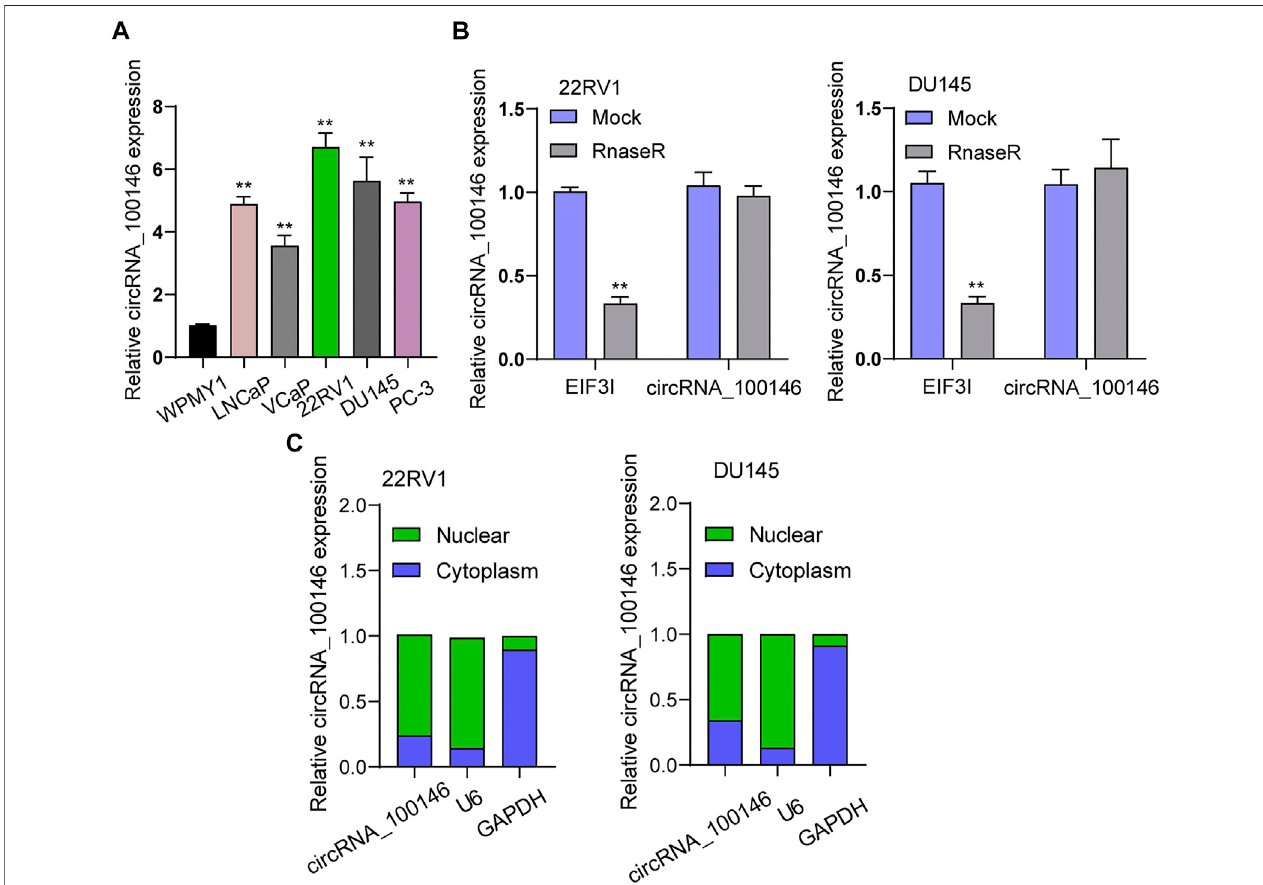
FIGURE 1 | CircRNA_100146 expression was upregulated in PCa cells. (A) RT-PCR determined the expression of circRNA_100146 in fi ve PCa cell lines and WPMY1cells. (B) RNaseRassayswerecarriedouttoverifythecircularcharacteristicsofcircRNA_100146in22RV1andDU145cells. (C) RT-PCRwasusedtoexamine relative circRNA_100146 expression levels in nuclear and cytosolic fractions of 22RV1 and DU145 cells. ** p < 0.01.